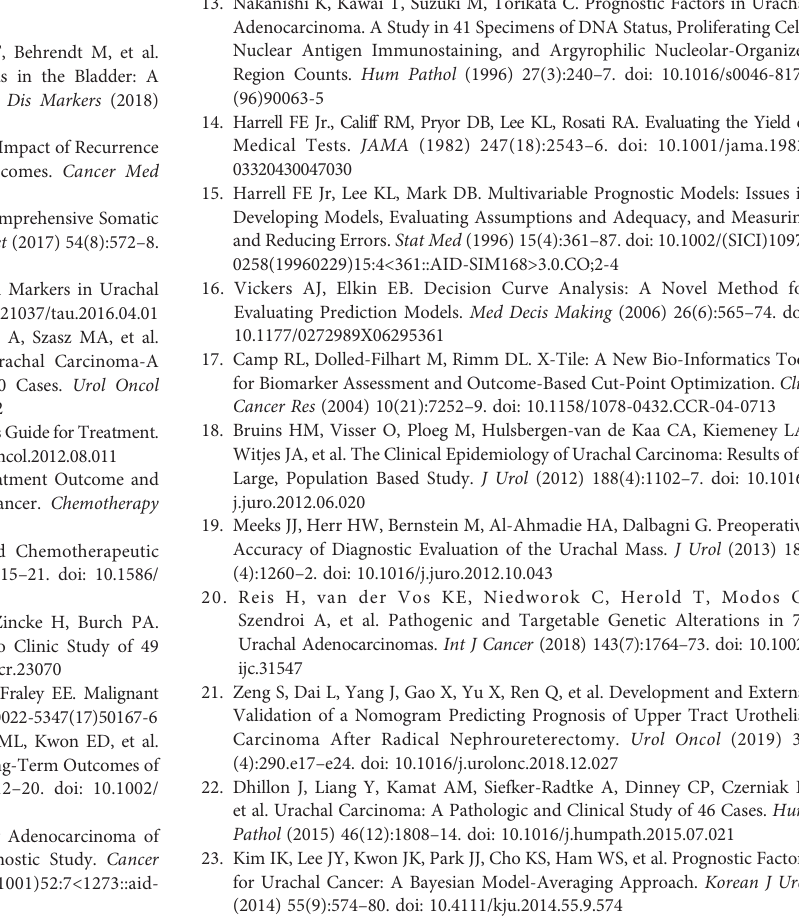
Supplementary Figure 1 | (A) Nomogram of TNM model for prediction of cancer speci fi c survival of urachal cancer; (B) Nomogram of Mayo model for prediction of cancer speci fi c survival of urachal cancer. Supplementary Figure 2 | (A) X-tile plots to identify the optimal risk score cutoff based on cancer speci fi c survival in the SEER training set. The X-tile plot was generatedbydividingriskscoresintothreepopulations(low,middleandhigh).Each pixel (point) of the X-tile plot represents the data from a given set of divisions. The X- axis represents all potential risk score cutofffrom low to high (left to right) that de fi ne low subset, whereas the Y-axis represents risk score cutoff value from high to low (top to bottom), that de fi ne a high subset. The arrows represent the direction in which the low subset (X-axis) and the high subset (Y-axis) increase in size. The coloration of the plot represents the strength of the association at each division, ranging from low (dark, black) to high (bright, red or green). Inverse associations between therisk scoreandsurvival arecolored red, whereas directassociationsare coloredgreen. Thepresent fi guresuggestedhigherriskscorecorrelatedwithworse prognosis. (B) The distributions of the number of patients by risk score, 9 and 13 was the optimal cutoff value to de fi ne low-, middle- and high-risk of urachal cancer. (C) Kaplan-Meier curves of different risk groups strati fi ed by the Sheldon model in the training